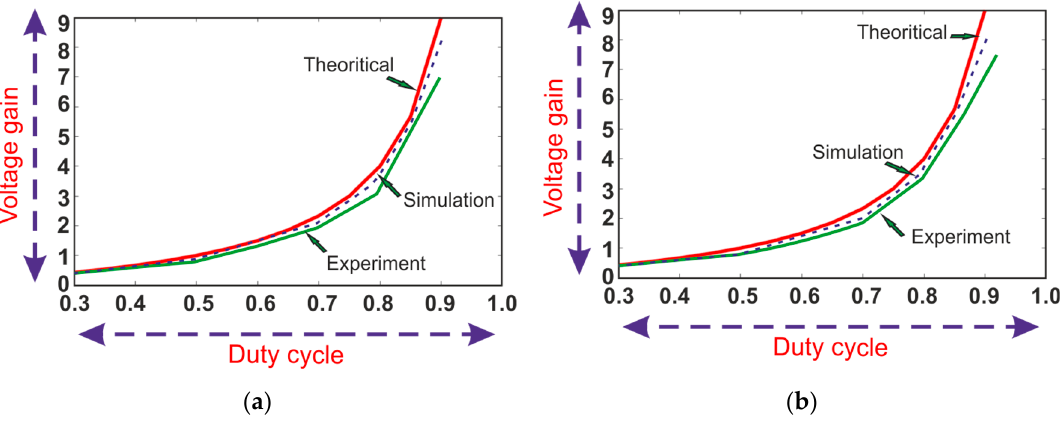
Figure 18. Voltage gain as a function of duty cycle ( a ) SISO mode ( b ) DISO mode.